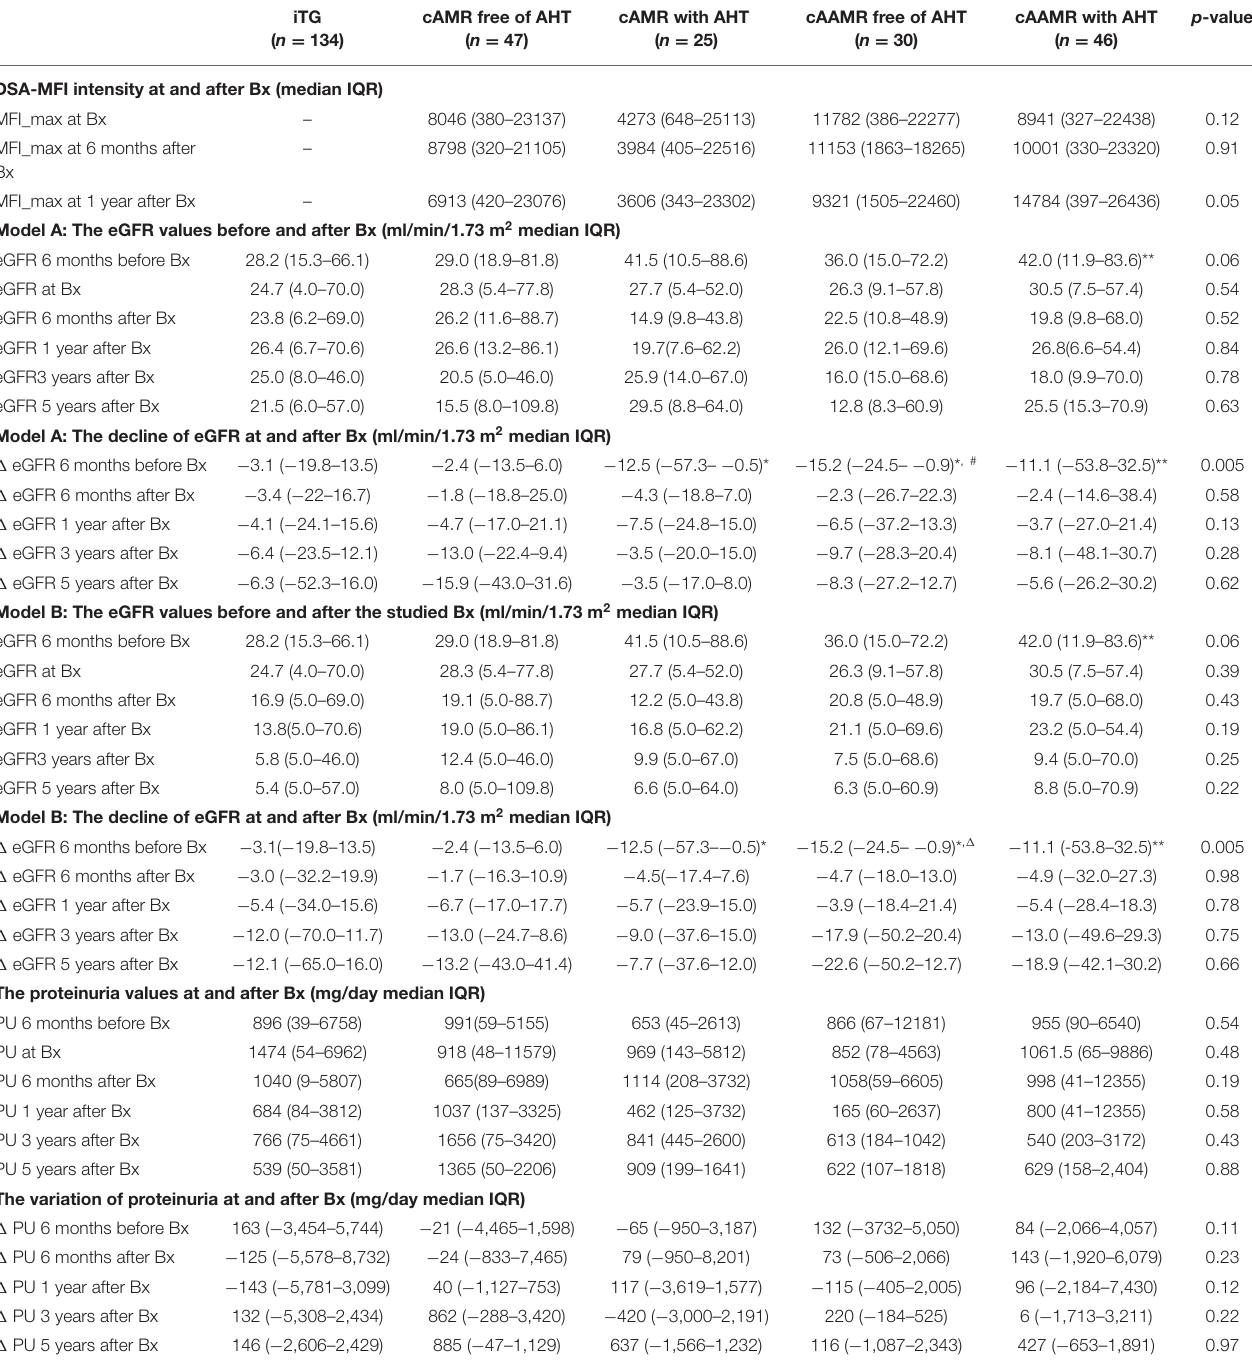
TABLE 3B | Variation of DSA, estimated glomerular filtration rate (eGFR), and proteinuria in relation to antihumoral therapy.